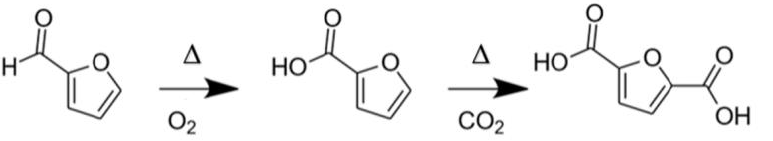
Figure 12. Two-step FDCA synthesis method of furfural using oxidation and carboxylation steps.